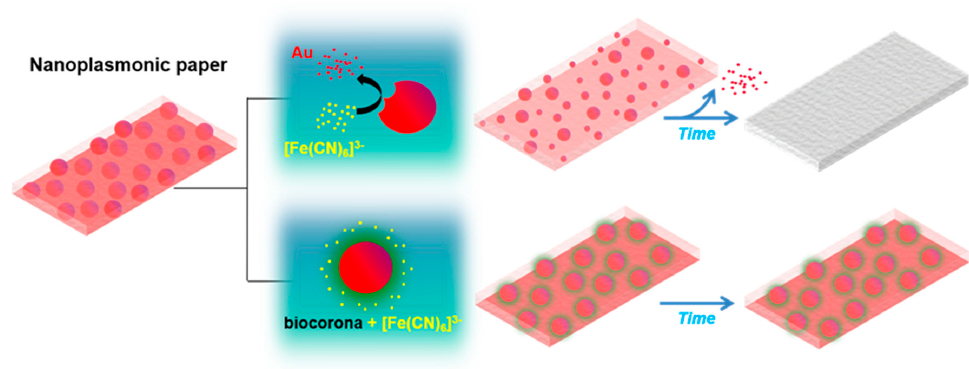
Figure 6. Illustration showing the colour evolution of the nanoplamonic paper in the presence or absence of biomacromolecules forming a biocorona.